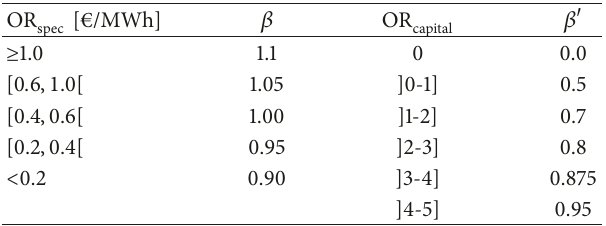
whereas costs for balancing energy depend on the deviation between the forecast and actual VRE generation.